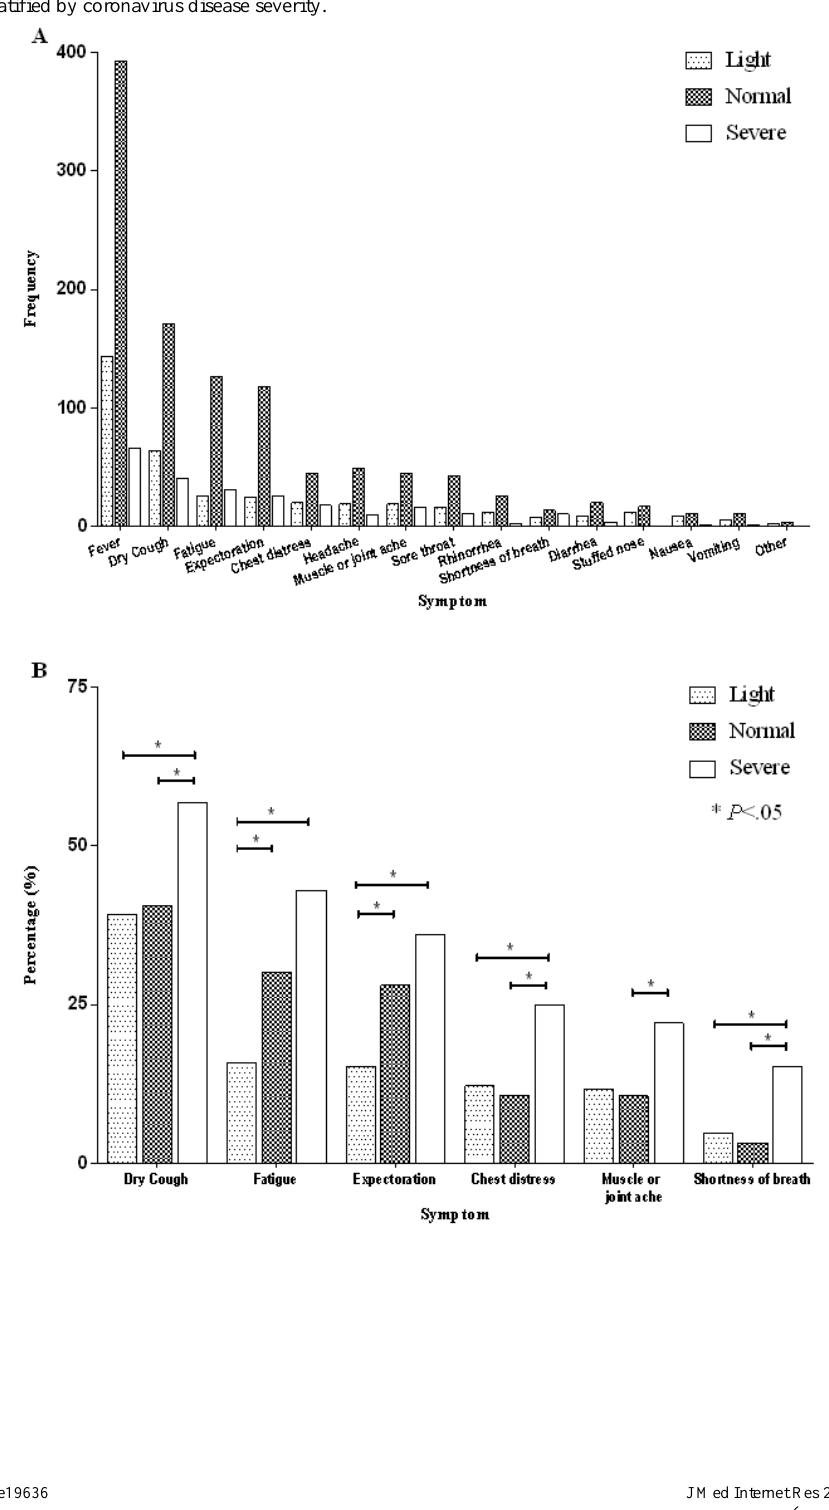
Figure 2. Summarized report of documented symptoms. Plots of (A) patient number of documented symptoms and (B) patient percentage of prognostic symptoms in cohorts stratified by coronavirus disease